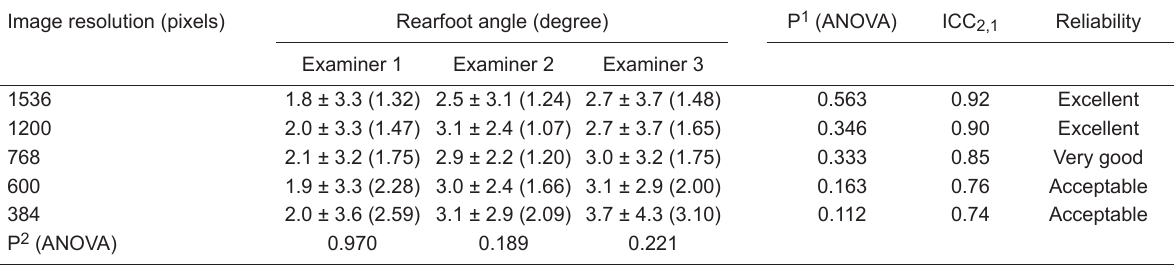
Data are reported as means ± SD with standard error of prediction within parentheses and were analyzed by ANOVA for repeated measures. P 1 ANOVA among examiners; P 2 ANOVA among resolutions. ICC 2,1 = intra-class correlation coefficients (inter-rater ICC 2,1